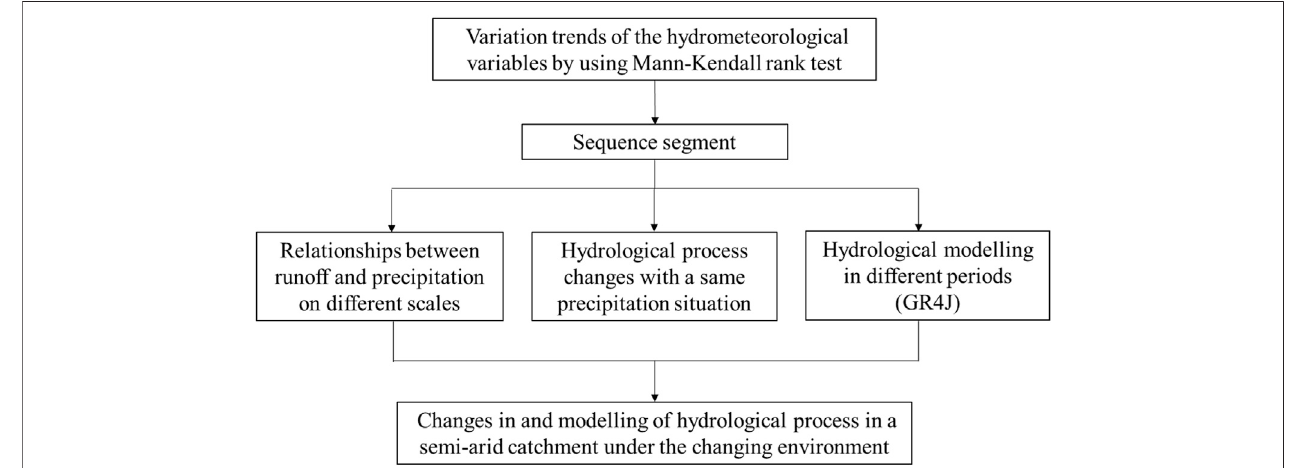
FIGURE 2 | Research